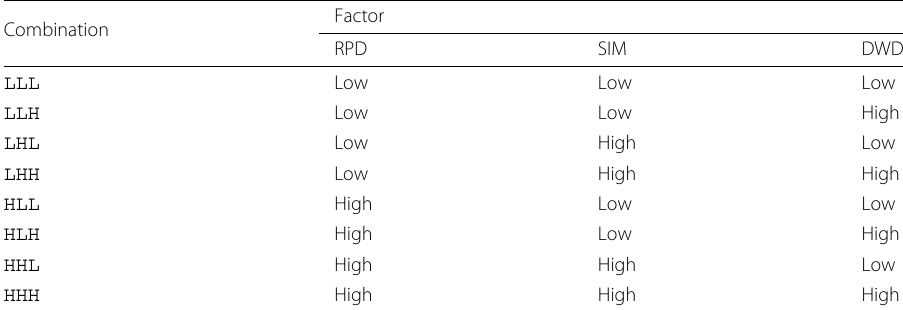
Table 2 Combinations of three factors